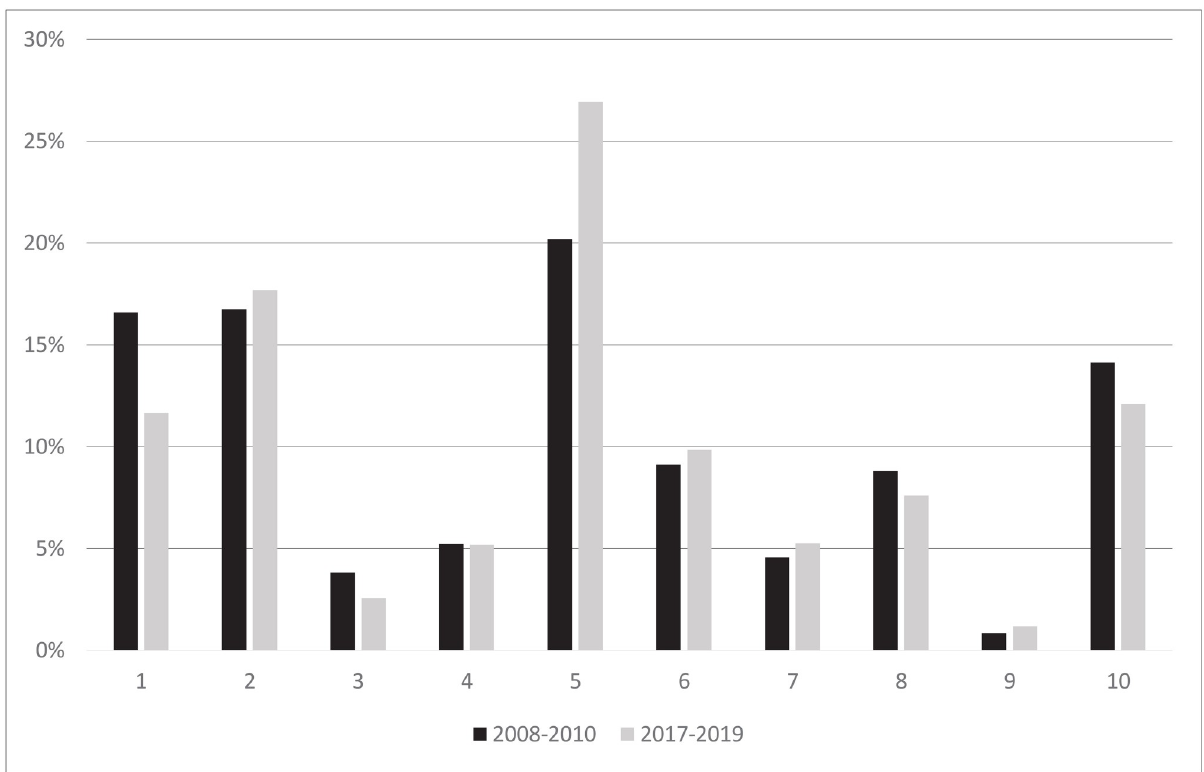
Fig 4. Relative contribution of each group. Comparison of the relative contribution of each group to overall caesarean delivery rate between the years 2008–2010 and 2017–2019 (data in percentage) calculated by dividing the number of caesarean deliveries in each group with the number of all caesarean deliveries in the observed time